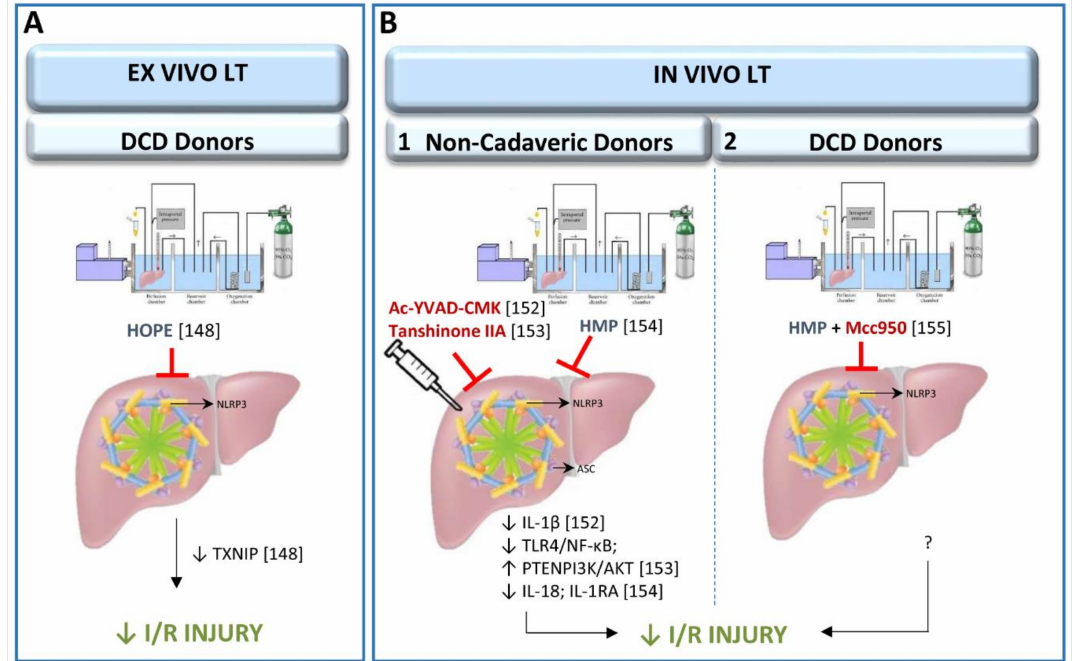
Figure 3. Schematic representation of the role of inflammasome in di ff erent experimental models of cold I / R injury. ( A ) ex vivo liver transplantation model. ( B ) in vivo liver transplantation from non-cadaverid donors (B.1) and from cardiac-circulatory death donors (B.2) models. Abbreviations: AKT, Protein kinase B; ASC, Apoptosis-associated speck-like protein containing a CARD; DCD, Cardiac-circulatory death; HOPE, Hypothermic oxygenated perfusion; HMP, Hypothermic machine perfusion; IL, Interleukin; IL-1RA, IL-1R antagonist; LT, liver transplantation; NF- κ B, Nuclear factor kappa-light-chain-enhancer of activated B cells; NLRP3, NLR pyrin domain containing protein 3; PI3K, Phosphoinositide 3-kinase; PTEN, Phosphatase and tensin homolog; TXNIP, Thioredoxin-interacting protein; TLR4, Toll-like receptor